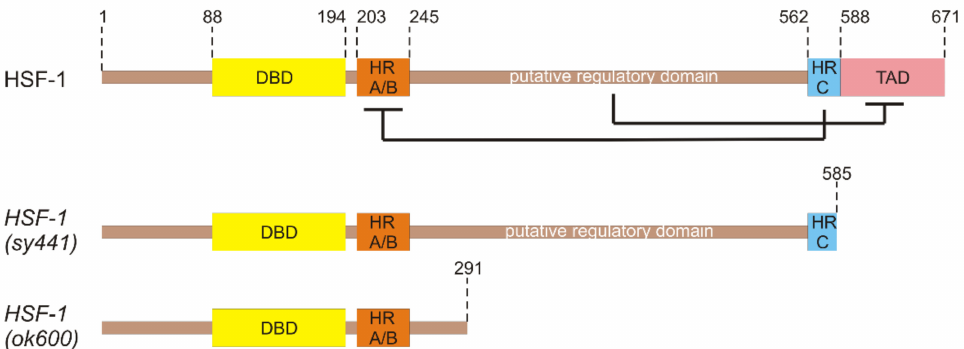
Figure 2. Domain structure of C. elegans HSF-1 full-length protein and the truncated alleles sy441 and ok600 . Numbers indicate amino acid positions. DBD is the DNA-binding domain, HR-A/B and HR-C are the trimerization domains and TAD is the transactivation domain. HSF-1 trimerization is negatively regulated by intramolecular interactions between the HR-A/B and the HR-C domains. The exact position of the regulatory domain in the C. elegans HSF-1 is not yet determined. However, it is most possibly located between the two trimerization domains and negatively regulates the trans-activating capacity of HSF-1. sy441 allele is lacking the transactivation domain, while ok600 allele is lacking both TAD and the putative regulatory